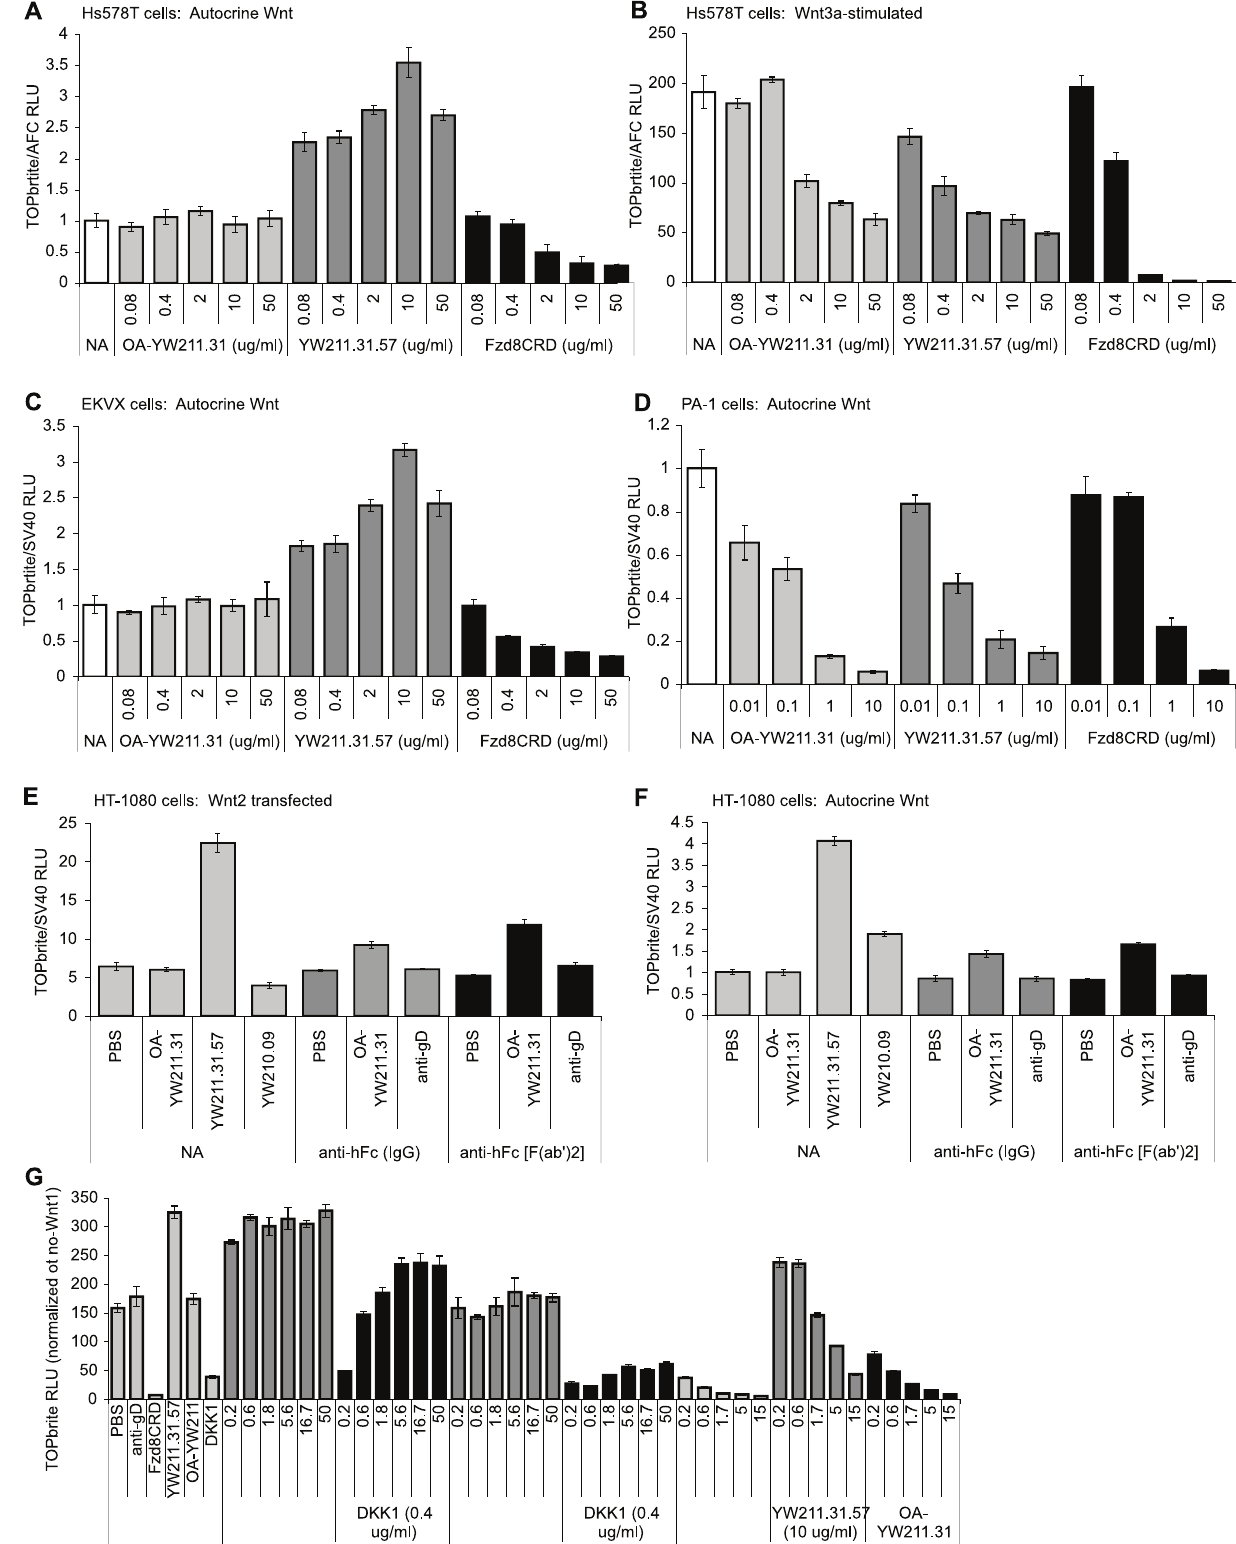
Figure 4. LRP6 antibody bivalency mediates potentiation of Wnt signaling. (A–D) One-armed (OA) YW211.31 antibody retains inhibitory activity similar in potency to the whole IgG against Wnt3a-induced signaling in Hs578T cells stably integrated with Wnt luciferase reporter (B) and against autocrine Wnt signaling in PA-1 cells transfected with reporter (D). The one-armed antibody lacks the potentiating effect of the intact